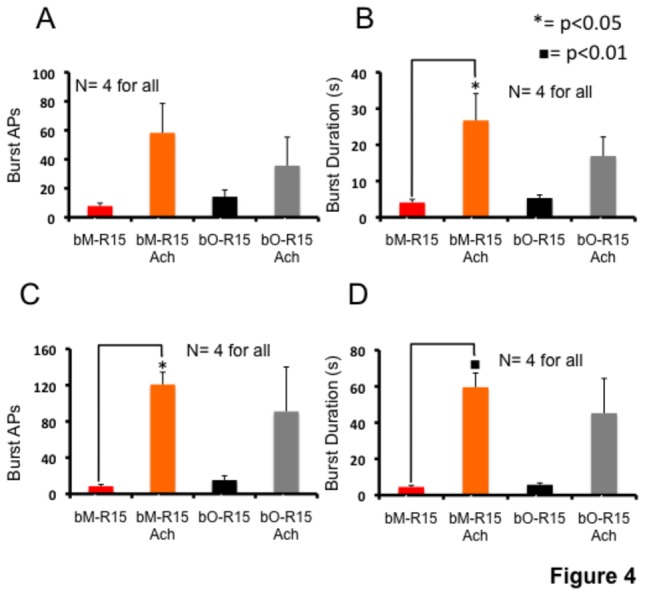
Analysis of burst firing of mature and old R15 neurons.Histograms showing the average number of APs (A) and average duration (B), of R15 bursts recorded from bO-R15 and bM-R15 neurons 90 seconds before and after application of 1 mM ACh. C and D: analysis of number of APs (C) and duration (D) considering only the first burst after ACh application. Values are expressed as mean ± SEM. s: seconds; an asterisk or a black-filled square indicates statistically significant differences. Differences were considered significant (n=4; One way ANOVA and Tukey’s HSD test) at the level of p < 0.05 (asterisk) or p < 0.01 (black filled square). bM-R15: rhythmic bursting R15 from mature animals; bO-R15: rhythmic bursting R15 from old animals, bM-R15 ACh and bO-R15 ACh are bM-R15 or bO-R15 neurons after ACh exposure.